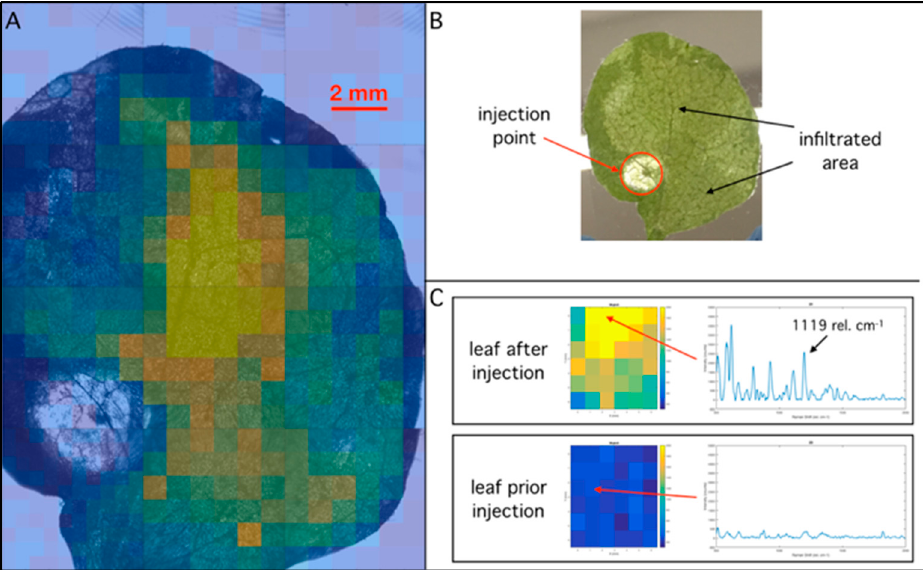
Figure 7. ( A ) Background subtracted Raman map (1119 rel. cm − 1 ) superimposed to its respective bright field image of a leaf infiltrated with labeled nanostars. ( B ) Image of the infiltrated leaf. ( C ) Raman maps of a section of the leaf before and after the injection of the nanostars. The spectra from one of the pixel of each map (indicated by the arrow) are shown on the side of the maps.